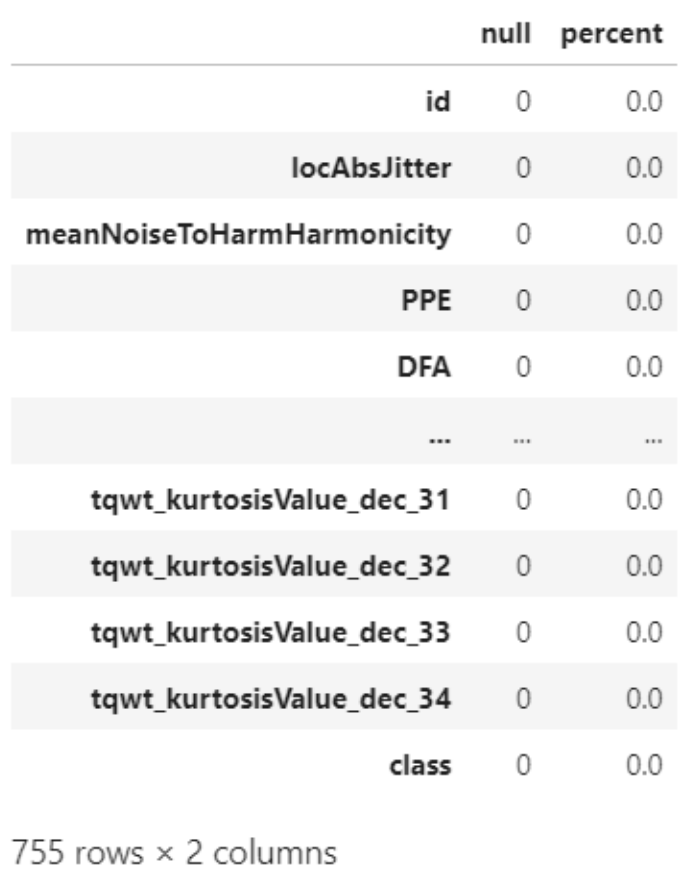
Figure 3. Checking for a missing value.